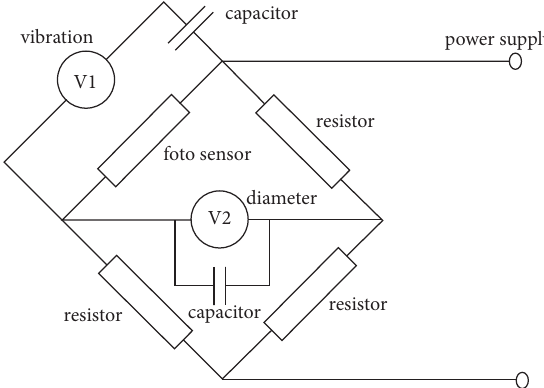
Figure 6: Separation of vibrations from the workpiece